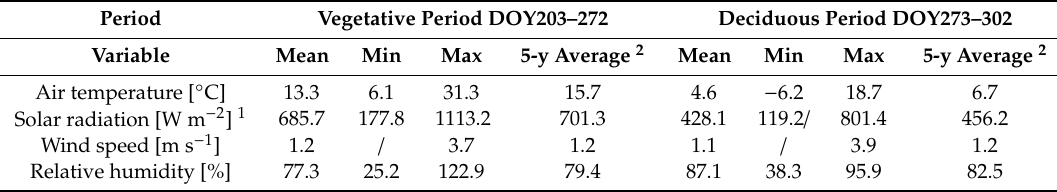
Table 1. Meteorological conditions in the study area.